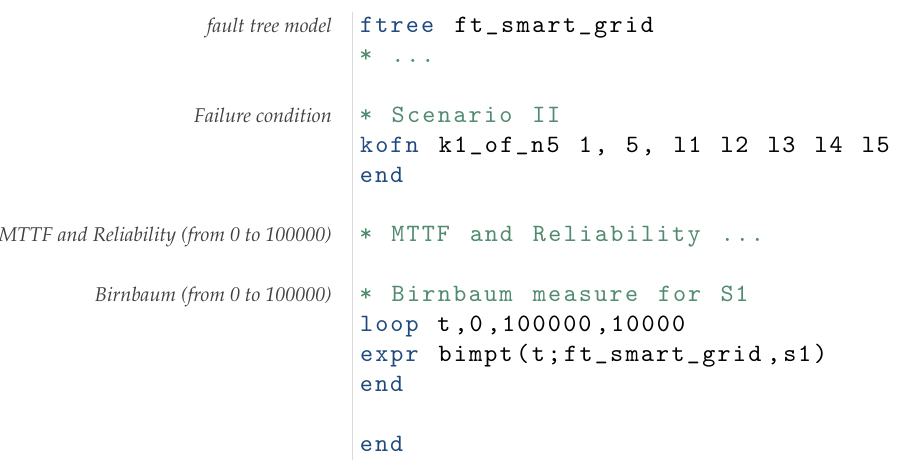
Figure 14. Failure condition and Birnbaum measure example for scenario II—case I ( SHARPE code).